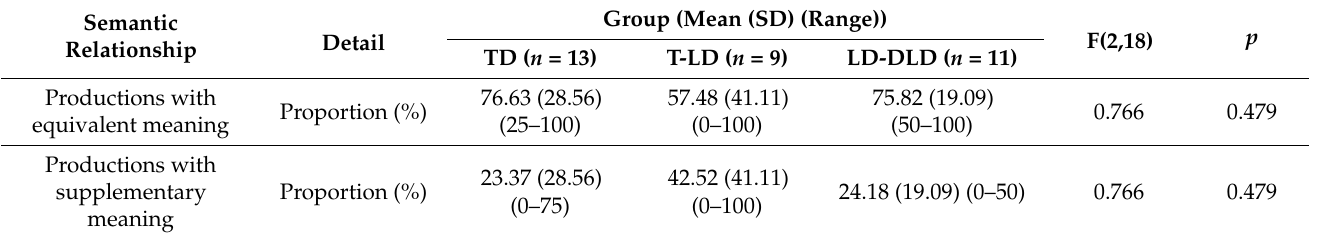
Table 5. Semantic relationships between representative gestures and words in bimodal